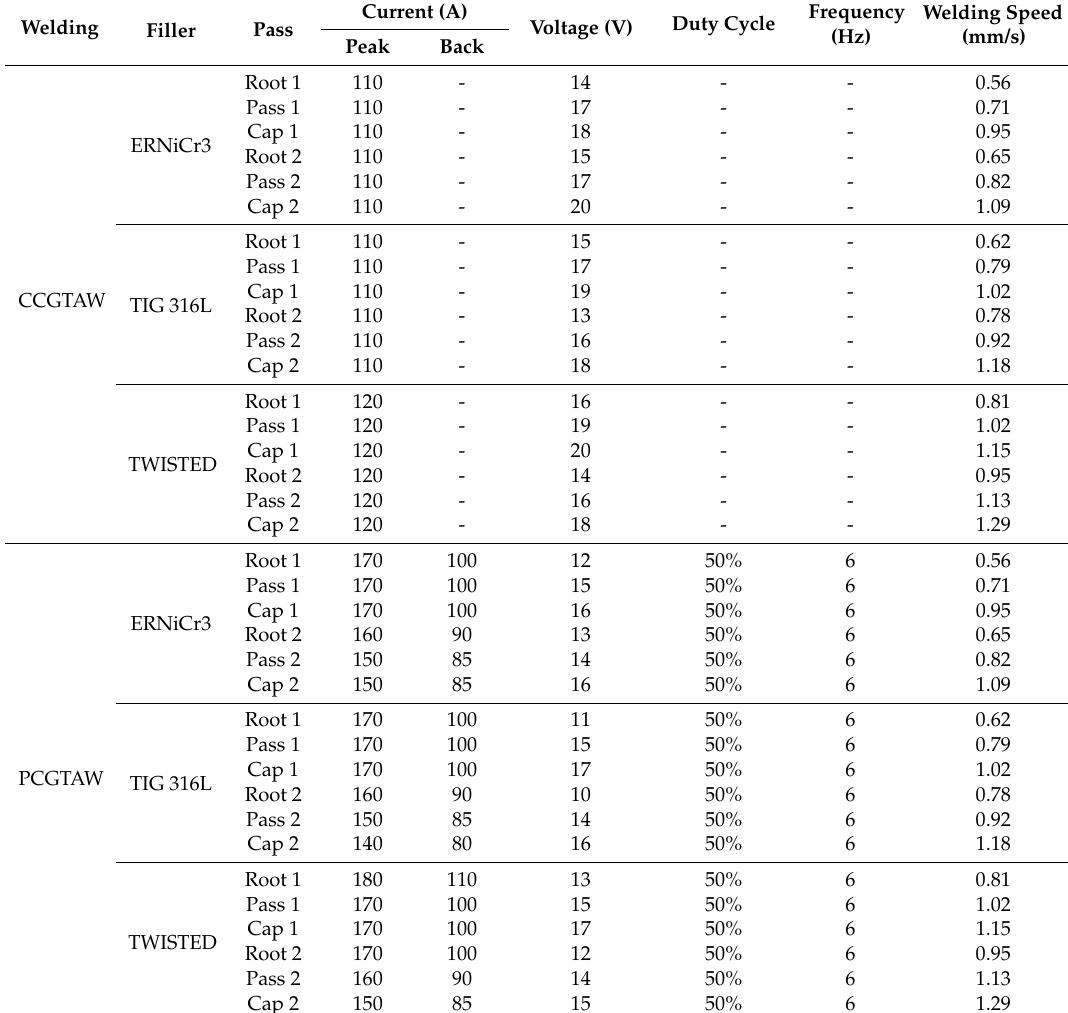
Table 2. Process parameters employed in Continuous Current Gas Tungsten Arc Welding (CCGTAW) and Pulse Current Gas Tungsten Arc Welding (PCGTAW).